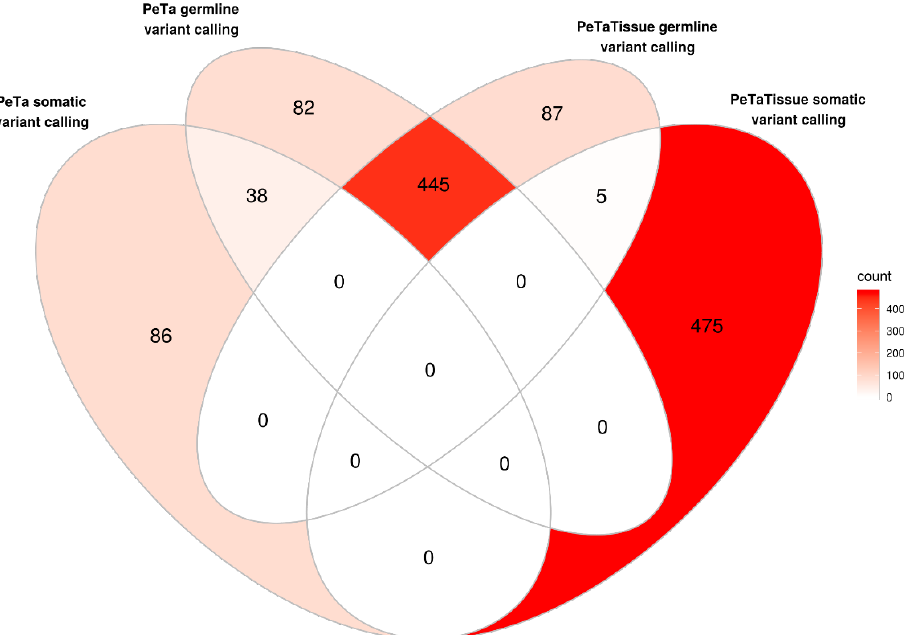
Figure 2. Comparison of unique mutations between PeTa and the respective tumor tissue. Venn- diagram showing how many of the same mutations are shared between the tumor cell line and tissue using either the tissue or the cell line as normal reference for somatic variant calling.